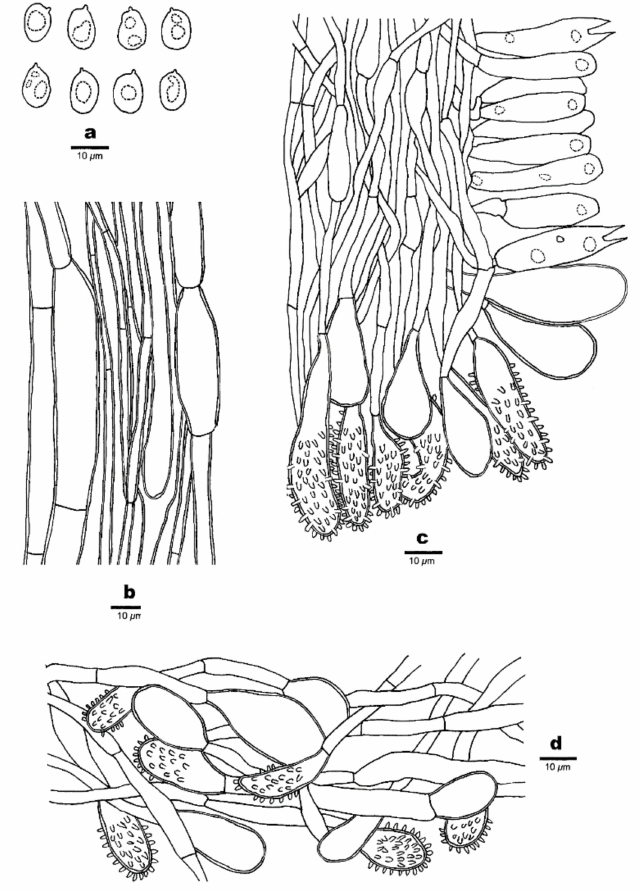
Figure 4. Microscopic structures of Favolaschia brevibasidiata. (Cui 6573, holotype). ( a ) Basidiospores. ( b ) Medullary hyphae of the stipe. ( c ) Hyphae at edge of pores showing gloeocystidia, acanthocystida, basidia and basidioles. ( d ) Hyphae of pileus cortex, composed of a hymeniform layer of acanthocysts and